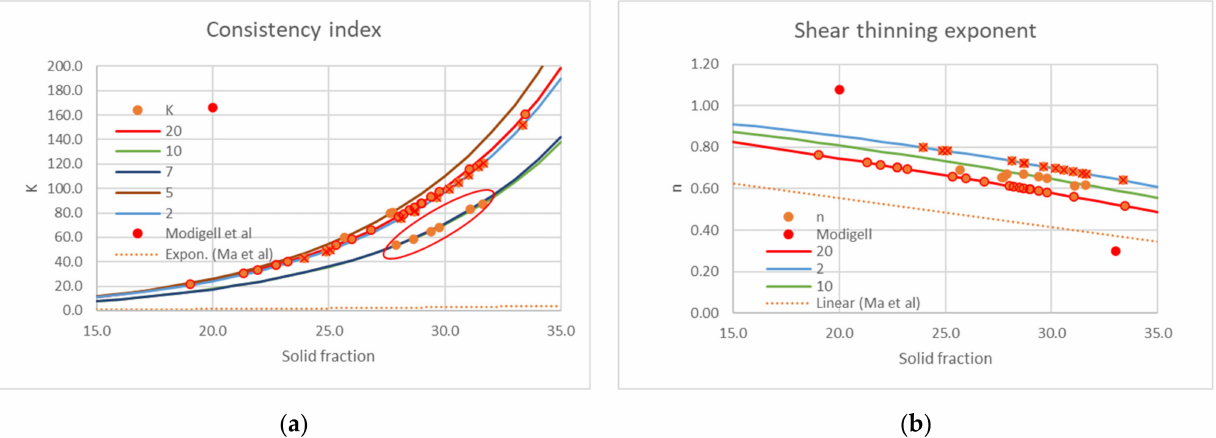
Figure 8. Factors included in the dynamic portion of the viscosity with: ( a ) the consistency index as a function of the solid fraction with the 10 and 7 kg shot weight experiments circled and ( b ) the shear-thinning exponent with data from Ma et al. [11] (dashed line) and Modigell et al. [6] (red dots) for comparison. Note that the orange markers are the experimental measurements, and the solid lines are the model predictions for the different shot weights with the colour-coding in the figure